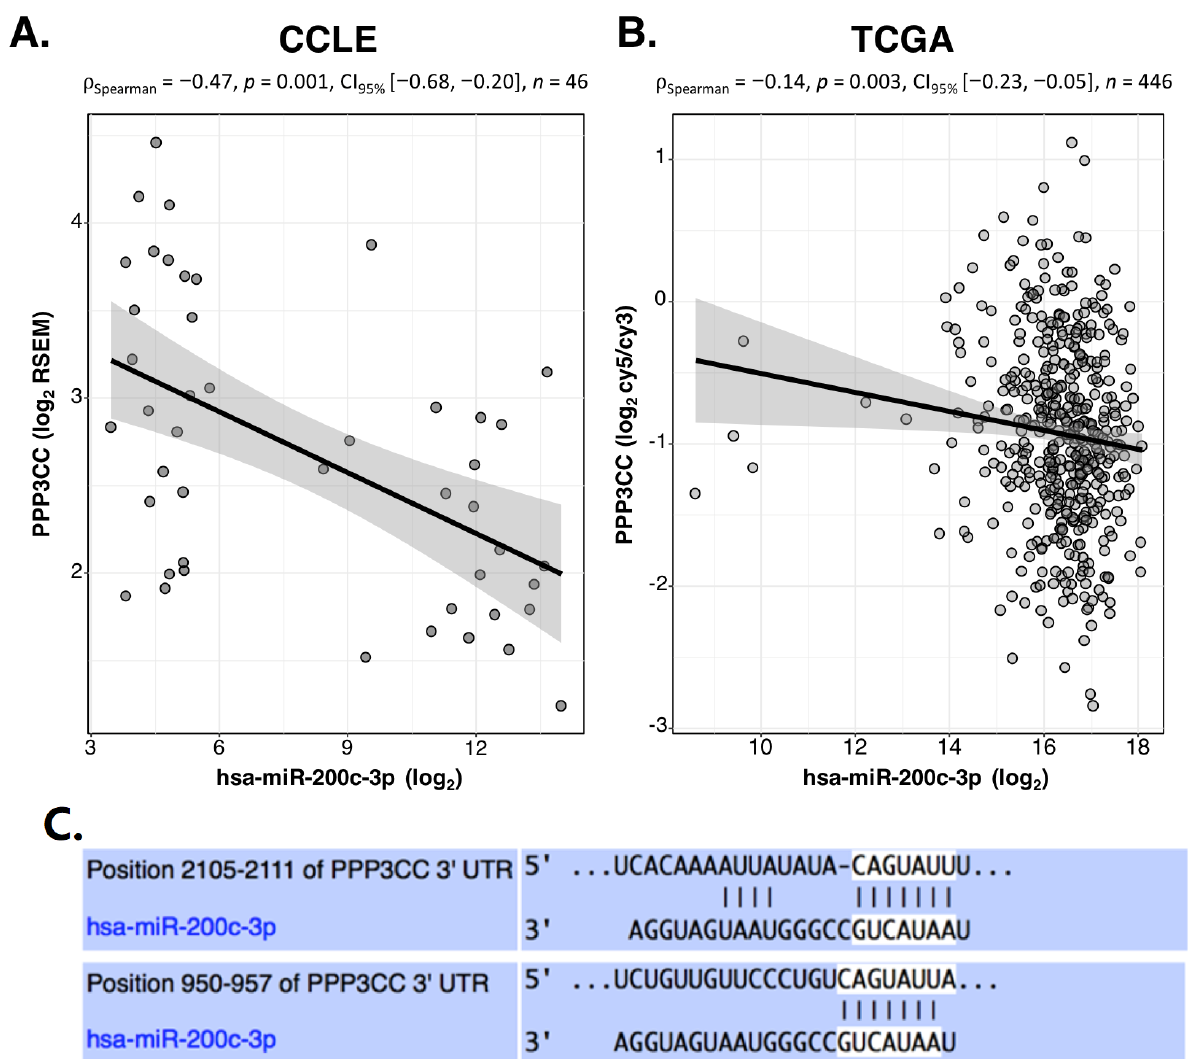
Figure 1. Inverse correlation between miR-200c-3p and PPP3CC through in silico analysis. ( A ). Correlation analysis between miR-200c-3p and PPP3CC in n = 46 OC cell lines, based on expression data from CCLE database. Spearman’s rank correlation coefficient was equal to −0.47 with p -value 0.001 ( B ). Correlation analysis between miR-200c-3p and PPP3CC in 446 EOC patients, based on expression data from TCGA. Spearman’s rank correlation coefficient was equal to − 0.14 with p -value 0.003. Data R package ggstatsplot (v. 0.7.2) was used to visualize the correlation analyses. ( C ). TargetScan algorithm was interrogated for miR-200c-3p binding sites to the 3′UTR of PPP3CC. Two binding sites for miR-200c-3p were identified at two different positions of the 3′UTR: at 2105-2111 nucleotides (nt) and at 950–957nt.